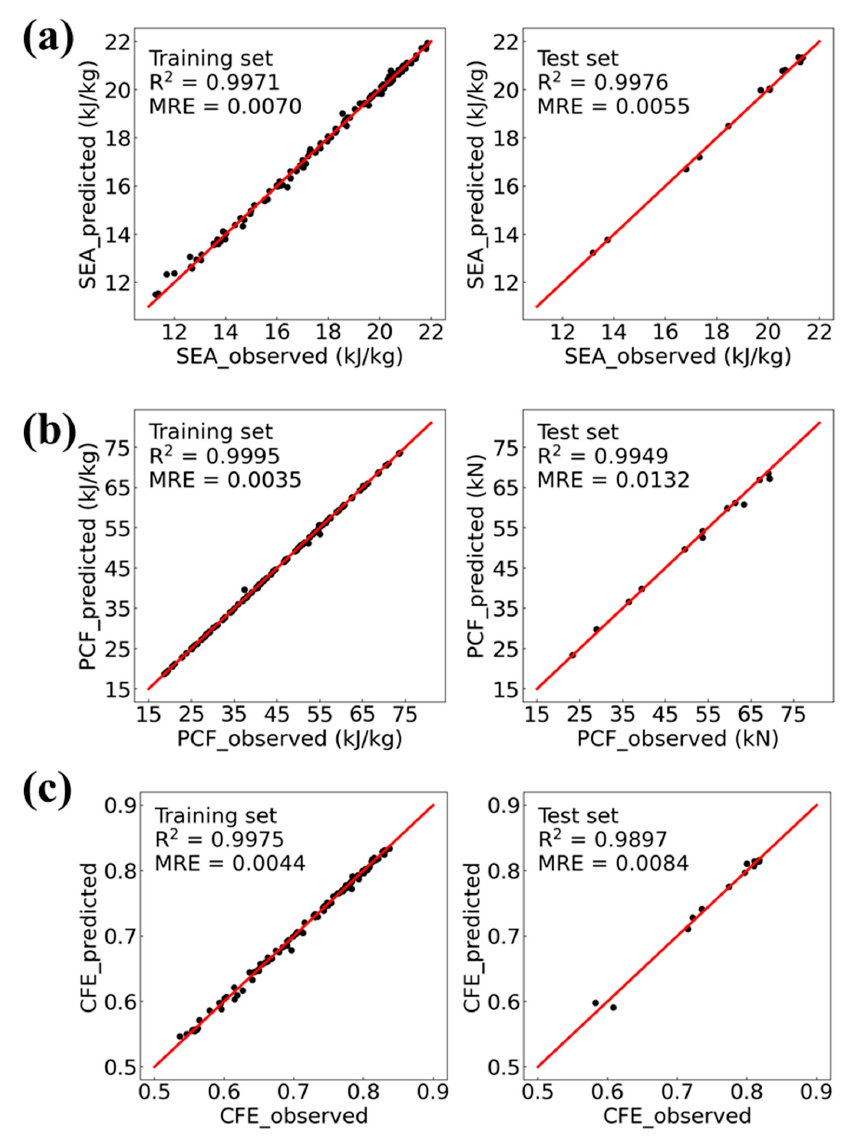
Figure 10. Performances of the prediction models for ( a ) SEA, ( b ) PCF and ( c ) CFE. Figure 11 shows the responses distribution under different geometers combinations.